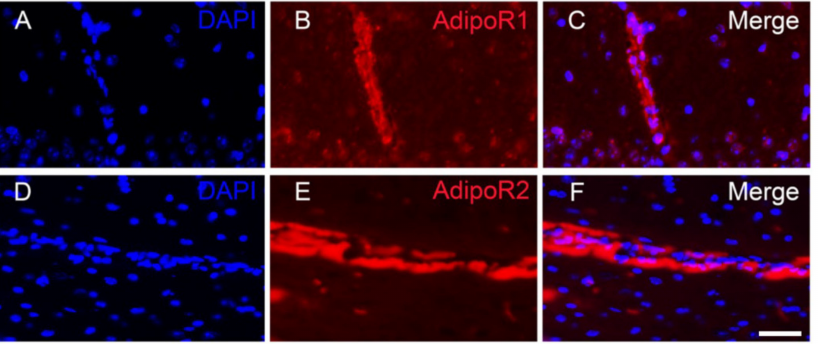
Figure 5. AdipoR1 and AdipoR2 are expressed in blood vessels. ( A – F ). AdipoR1 and AdipoR2 immunostaining (red) delimits blood vessel-like structures. In blue: DAPI counterstaining. Scale bar = 40 µ